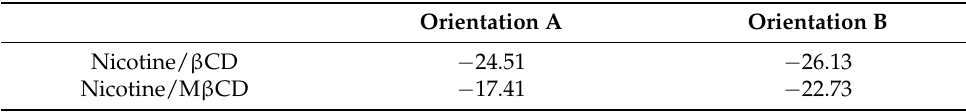
Table 1. The calculated complexation energy ( ∆ E ), in kcal/mol, of the nicotine inclusion complex with β CD and M β CD.